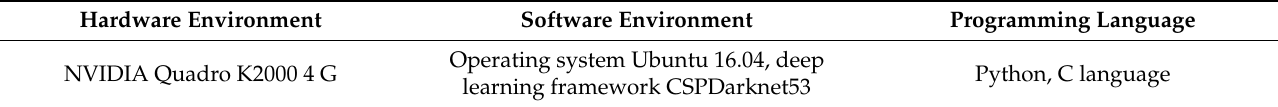
Table 3. Training environment parameters for flame detection